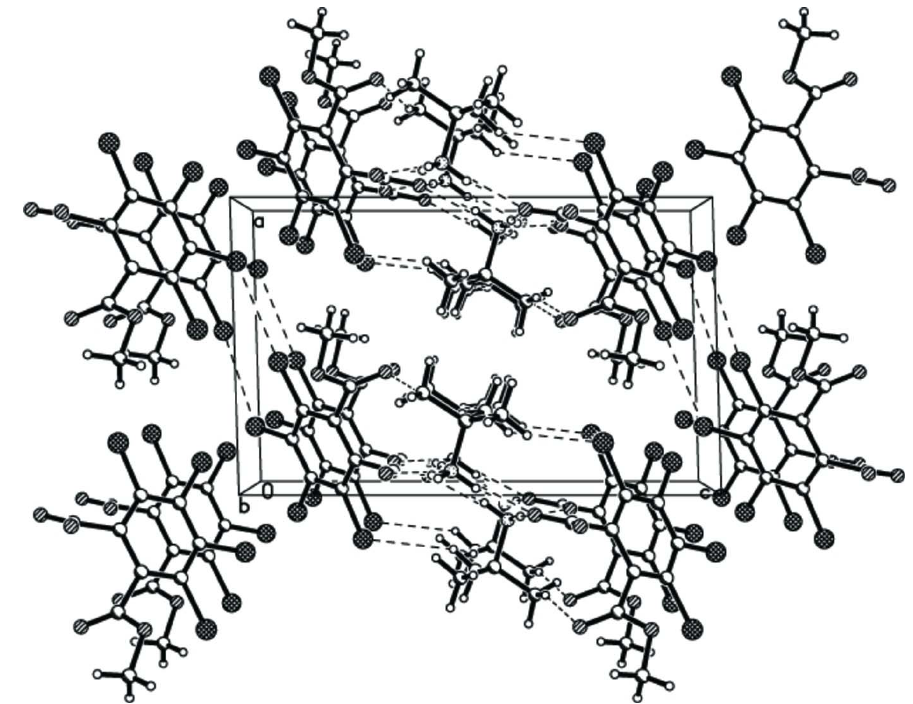
Figure 2 Part of the crystal structure of (I) with hydrogen bonds indicated by dashed lines. tert-Butylammonium 2,3,4,5-tetrachloro-6-methoxycarbonylbenzoate Crystal